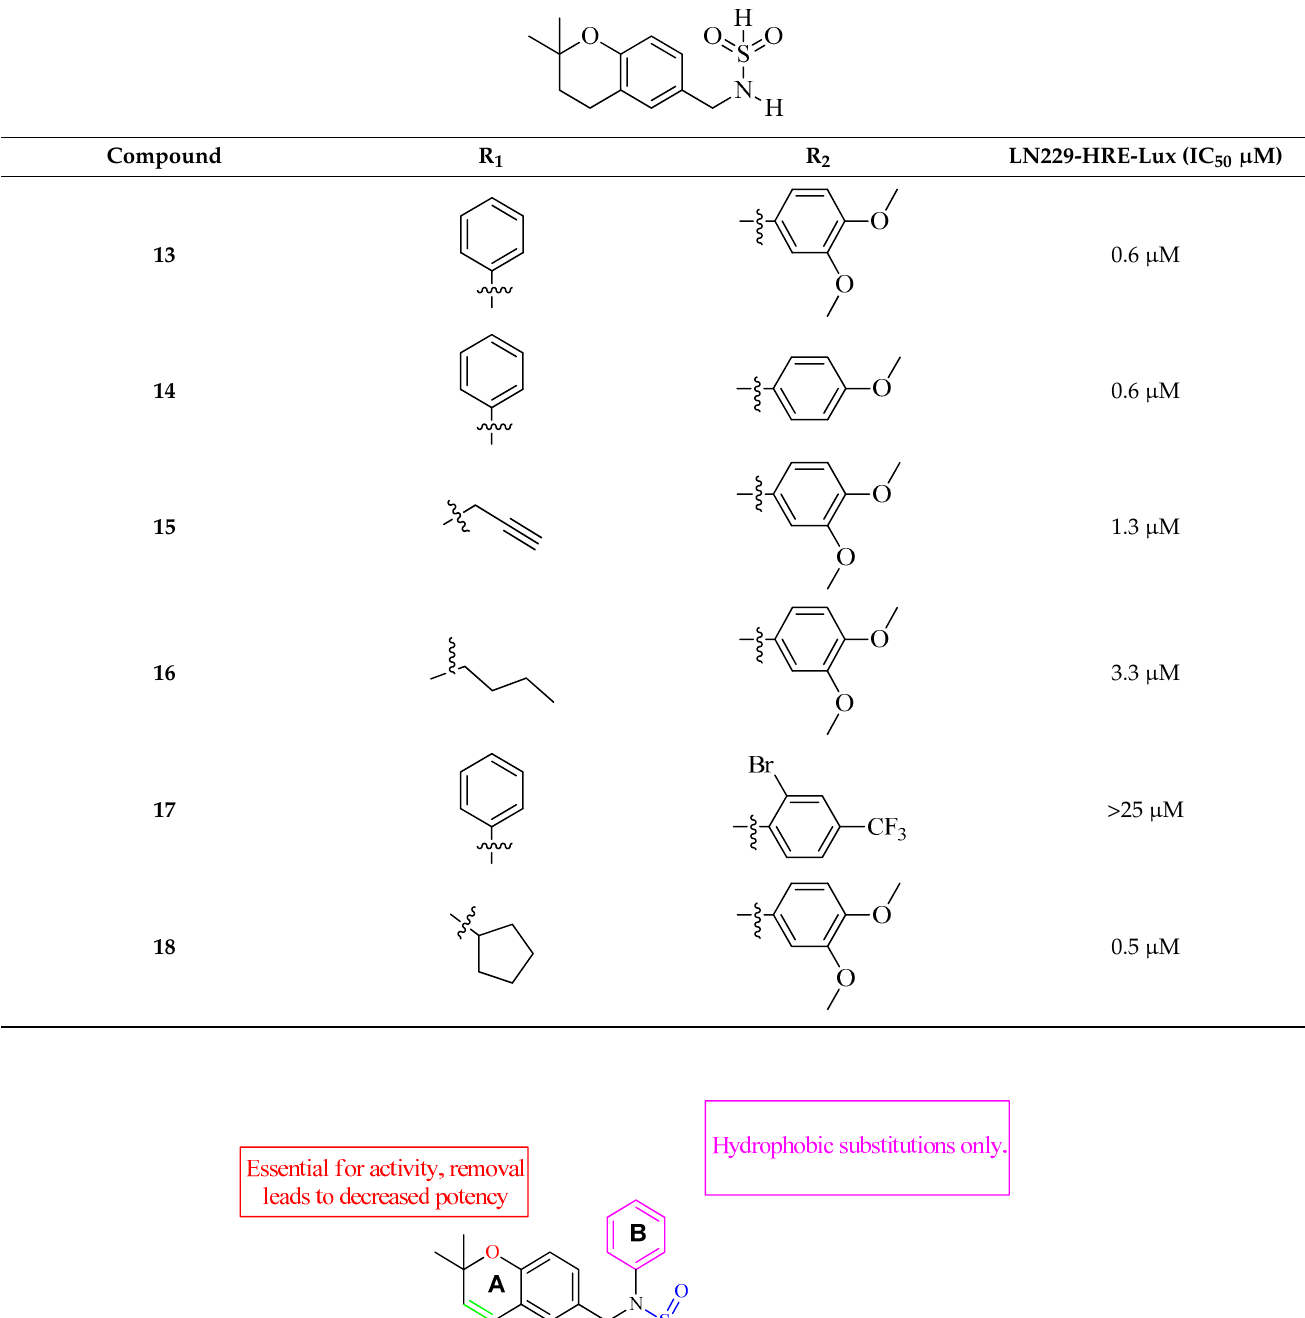
the benzenesulfonamide analogues ( 13 – 18 ) [72].